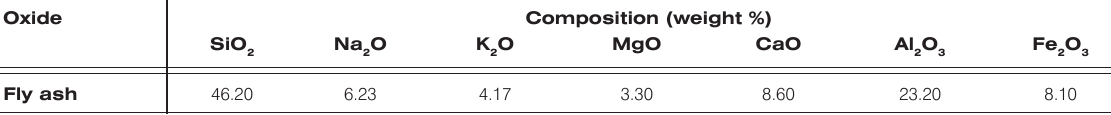
Table 3. Batch composition (weight ratios). Tableware